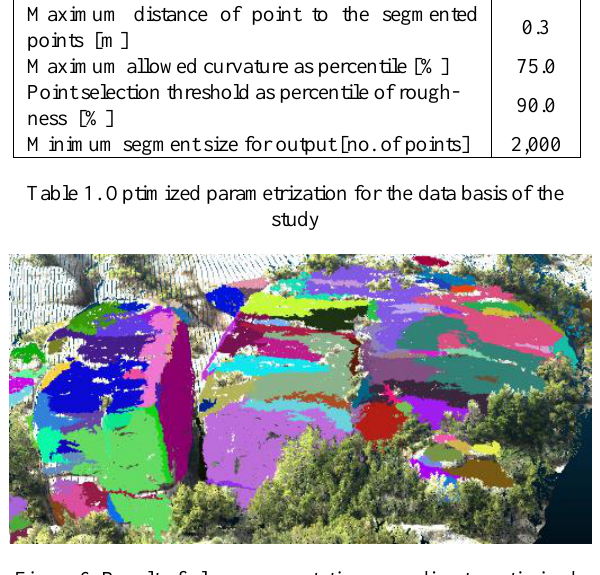
Figure 6. Result of plane segmentation according to optimized parametrization for the data basis of the study (Tab. 1) fit onto true color display